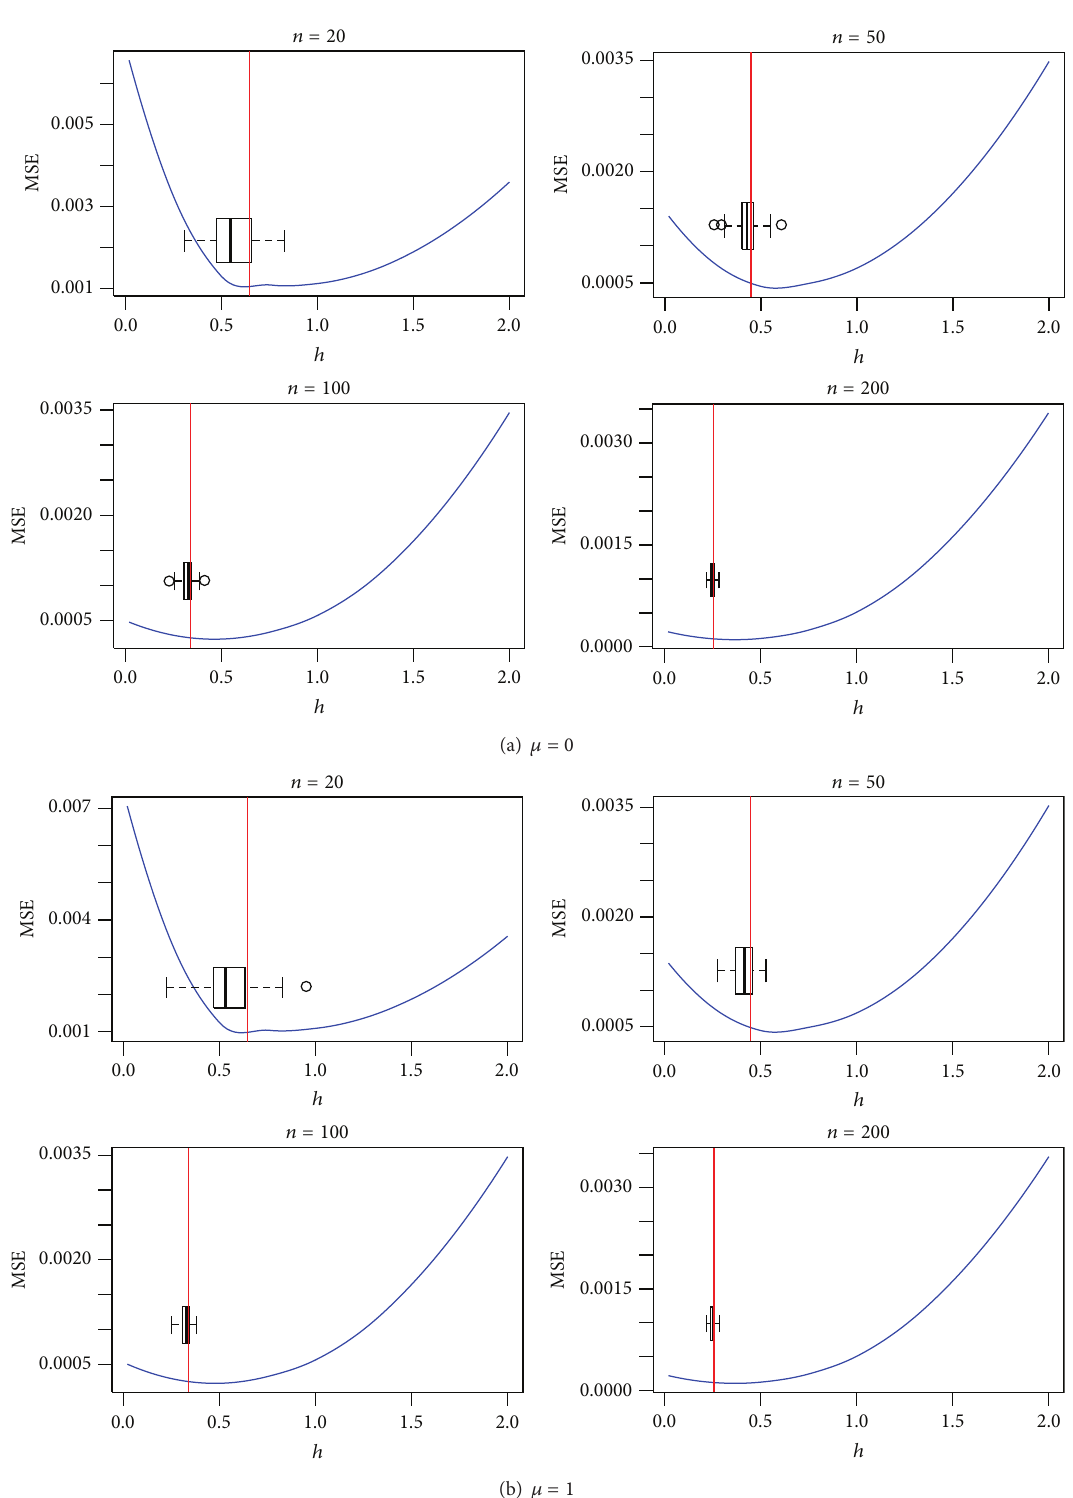
̂𝑈 𝜇 = 0 (a), 𝜇 = 1 (b) and standard deviation √ 2. The blue curve Figure 1: The MSE of 1 when underlying distribution is Normal with mean ̂𝑈 ℎ . The boxplot of ̂ ℎ is based on the 100 sets of simulated samples of size 𝑛 = 20 , 50 , 100 , 200 from is the MSE( 1 ) versus the bandwidth ROT ;𝑈 1 Normal distribution with mean 𝜇 and standard deviation √ 2. The red vertical line represents ℎ if 𝑓 is Normal with known mean 0 and AMSE ;𝑈 1 variance 𝜎 2